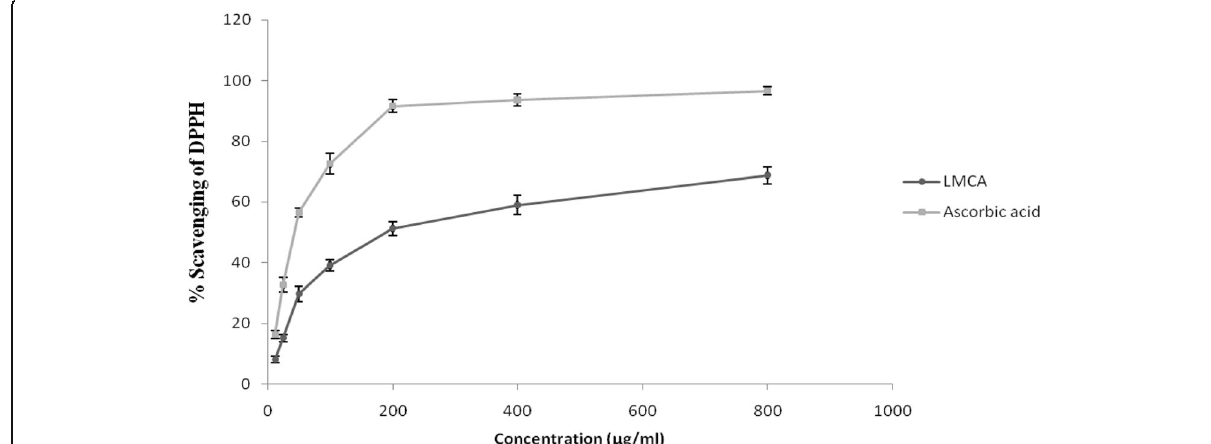
Fig. 3 DPPH radical scavenging activity of leaf methanolic extract of Colocasia affinis Schott along with standard Ascorbic acid. (Mean ± SD, n = 3)